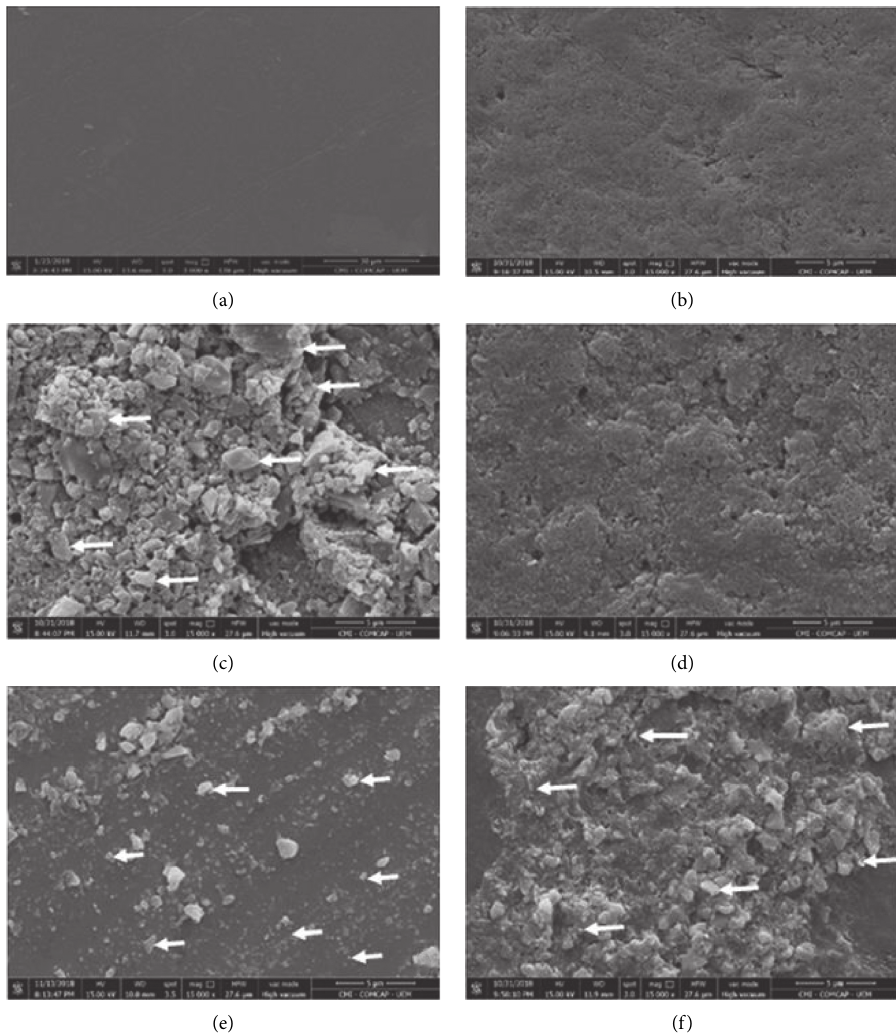
Figure 5: Representative scanning electron micrographs of the enamel surface morphology. The arrows indicate the presence of precipitates; (a) intact enamel—IE: is observed a smooth surface due to sequential polishing; (b) demineralized enamel—DE: disorganized enamel surface is observed; (c) silver diamine fluoride—SDF: presence of a layer with agglomerated precipitates (arrow) and heterogeneous on demineralized enamel surface treated with SDF; (d) fluoride—F: can be observed a disorganized enamel surface; (e) silver—Ag: scattered areas of enamel precipitates (arrow); (f) silver nanoparticles and fluoride—AgF: presence of a layer with precipitates (arrow) agglomerated and heterogeneous on the surface of decayed enamel treated with